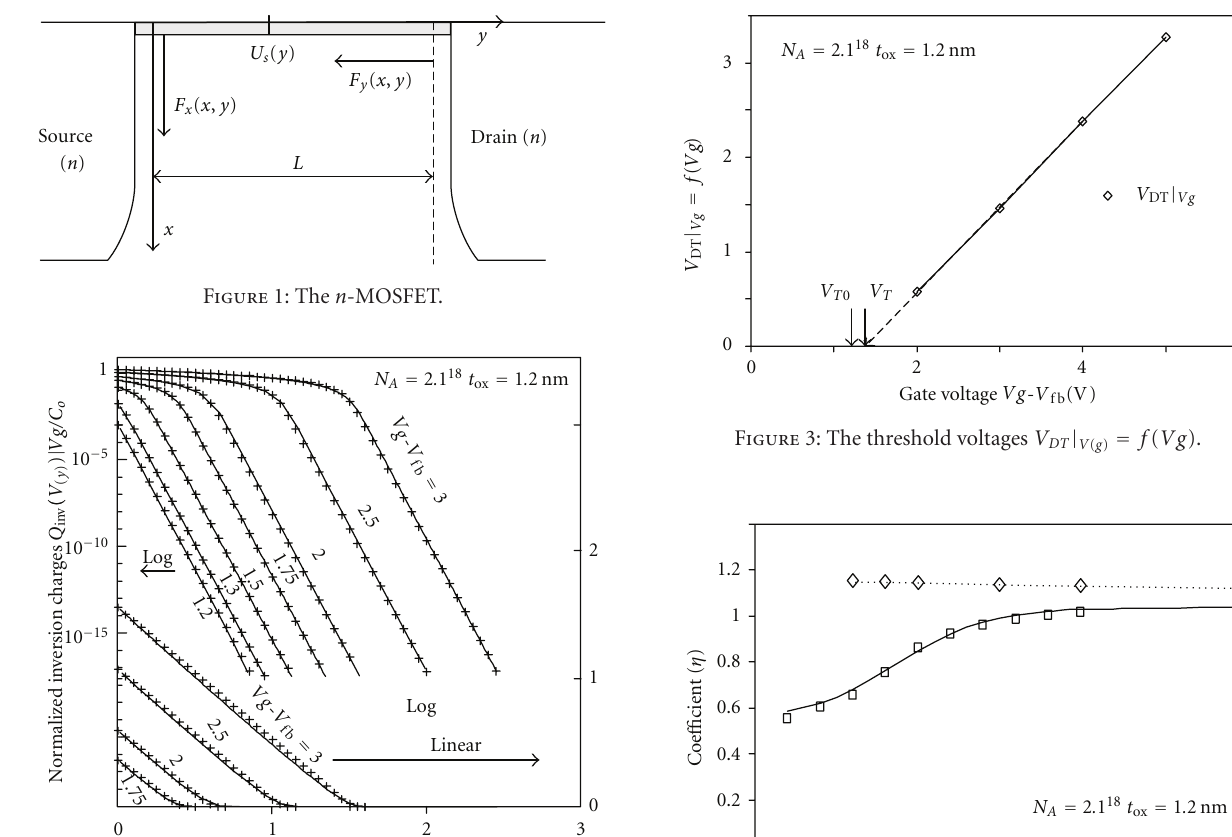
, V ( y )] plots in logarithm and Vg